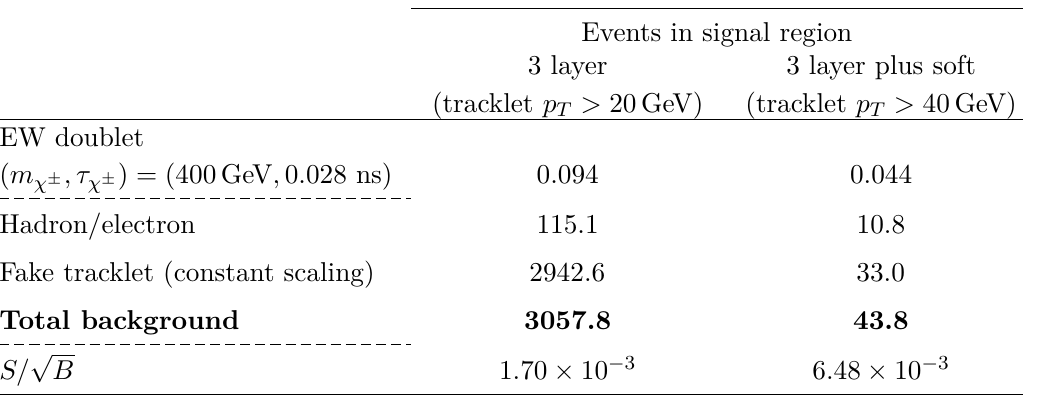
Table 5 . Number of signal and background events for our benchmark signal point, normalized to a luminosity of 36.1 fb − 1 , for searches proposed in this